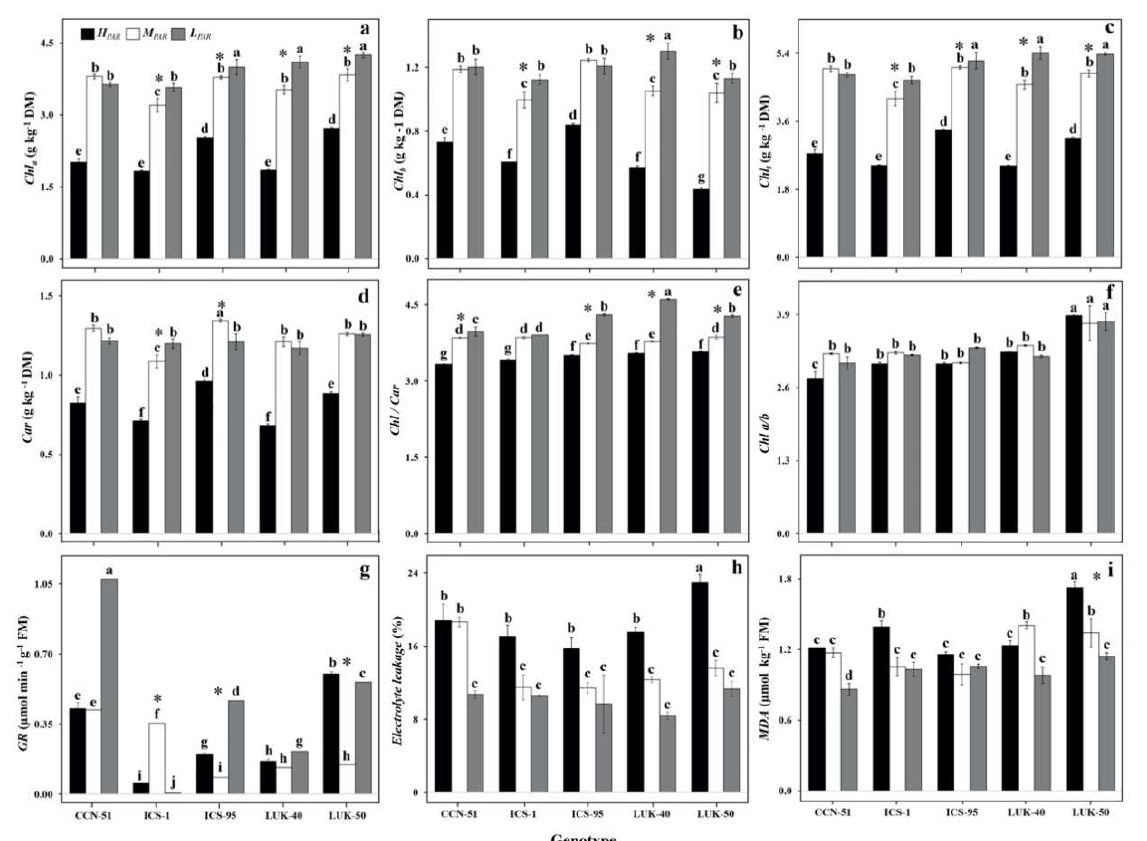
Figure 6. Biochemical assays for five genotypes of cacao in three levels of radiation. ( a ). Chl a : chlorophyll a; ( b ). Chl b : chlorophyll b; ( c ). Chl t : Total chlorophyll; ( d ). Car: Carotenoid; ( e ). Chl t /Car: Total chlorophyll/ carotenoids ratio; ( f ). Chl a /Chl b : chlorophyll a/b ratio; ( g ). glutathione reductase (GR; µmol min –1 g –1 FM); ( h ). electrolyte leakage (µmol kg –1 FM) and ( i ) concentration of malondialdehyde (MDA; µmol kg –1 FM). a,b,c : Values in bars with different letters indicate significant differences between genotypes of cacao × radiation level (post hoc LSD Fisher, p < 0.05). *: Means statistical differences between radiation levels in each cocoa genotype . The results include means ± SE ( n = 4).